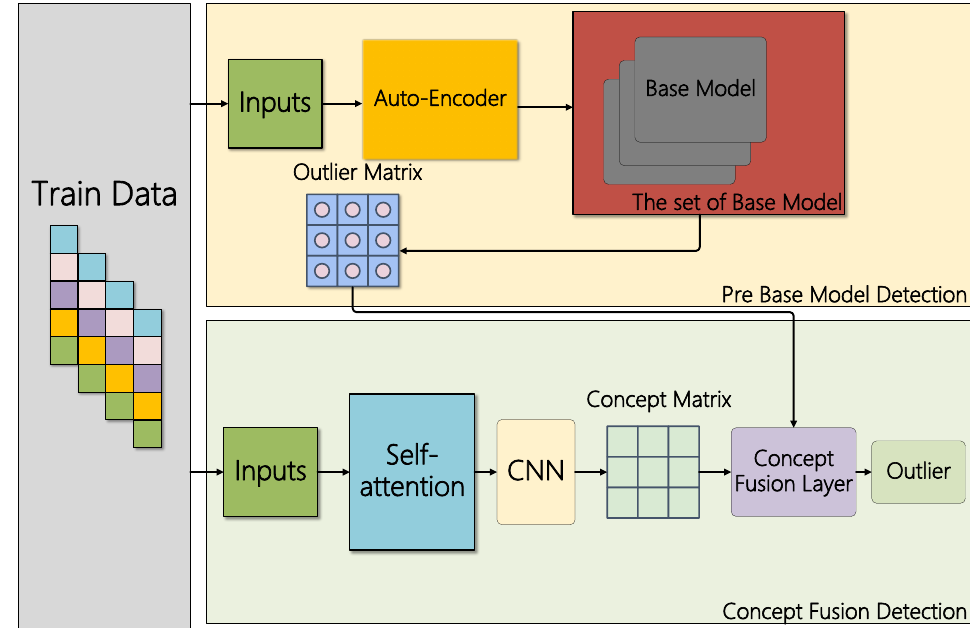
Figure 2. Adaptive ensemble learning model based on the self-attention mechanism.